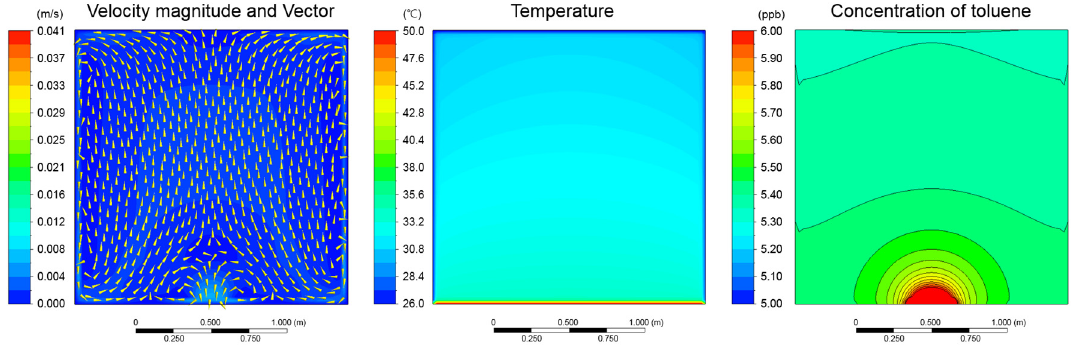
Figure 7. Concentrations of pollutants per case: ( a ) Case 1; ( b ) Case 2; ( c ) Case 3; ( d ) Toluene concentration of each case. CFD: computational fluid dynamics.